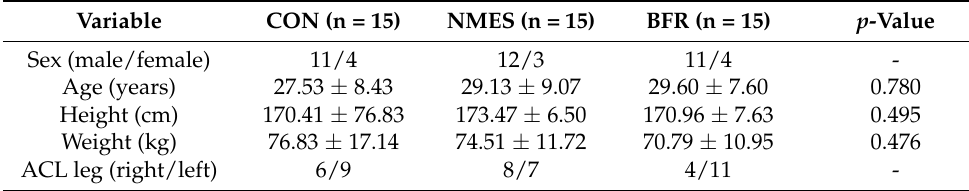
Table 1. Participants’ characteristics.